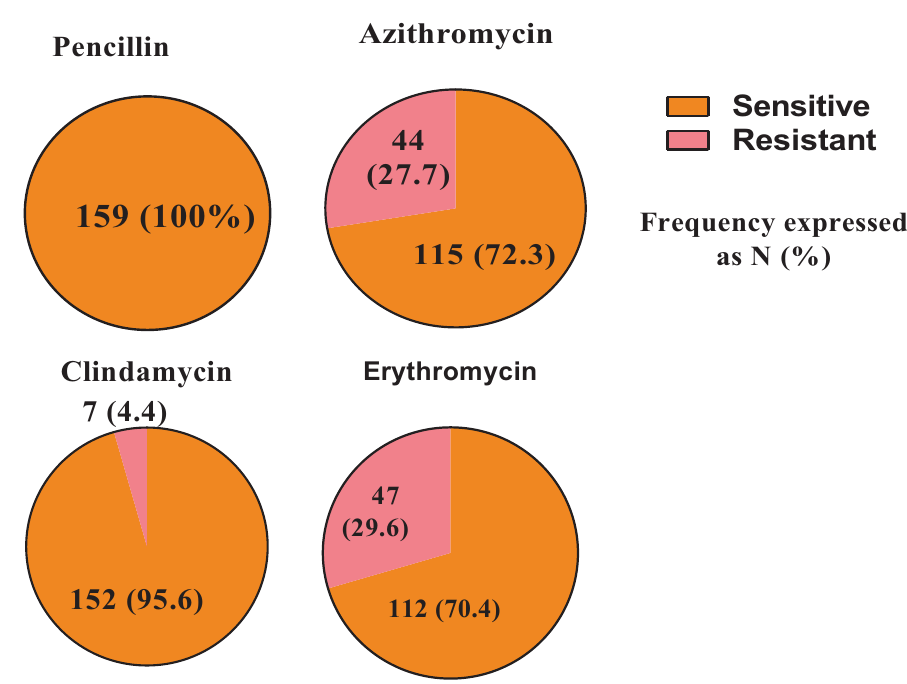
Figure 3 : Susceptibility of the isolated GAS to antibiotics. GAS, Group A streptococci; N,